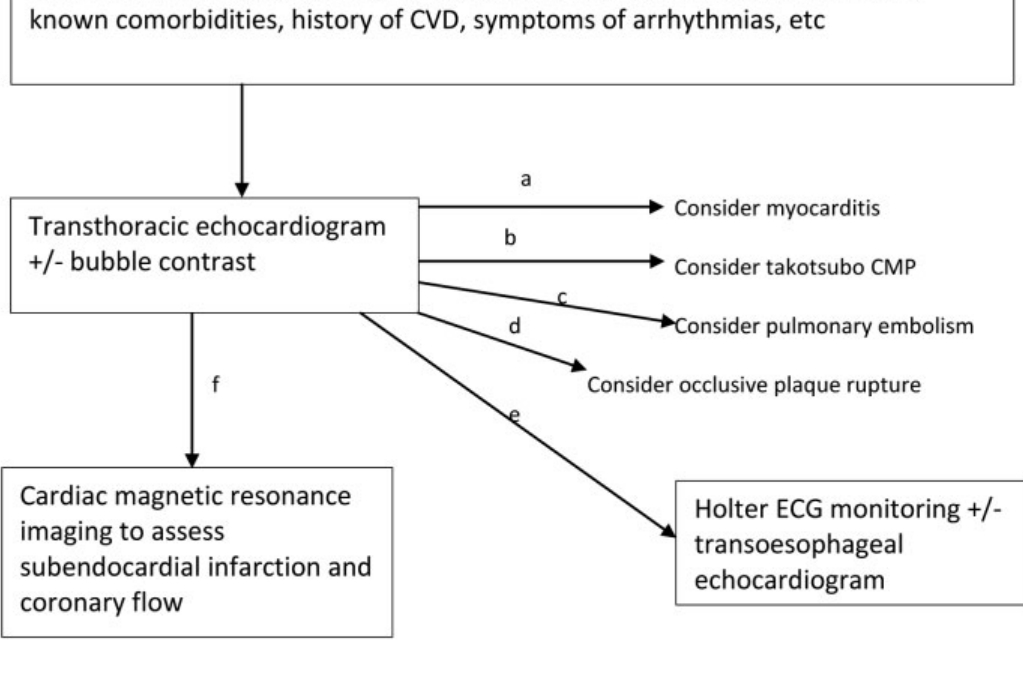
Fig. 2 Proposed algorithm for investigating MINOCA in limited-resource settings. (a) If global hypokinesia with reduced ejection fraction (particularly if new onset). (b) If apical hypokinesia/akinesia with ballooning. (c) If right ventricular dysfunction, D-shaped left ventricle in diastole. (d) If segmental hypokinesia/akinesia with/without aneurysm. (e) If cardiac arrhythmia suspected with no prior documented evidence. (f) If no diagnosis apparent from echocardiogram. CMP, cardiomyopathy; CVD, cardiovascular disease; ECG, electrocardiogram; MINOCA, myocardial infarction with nonobstructive coronary arteries.